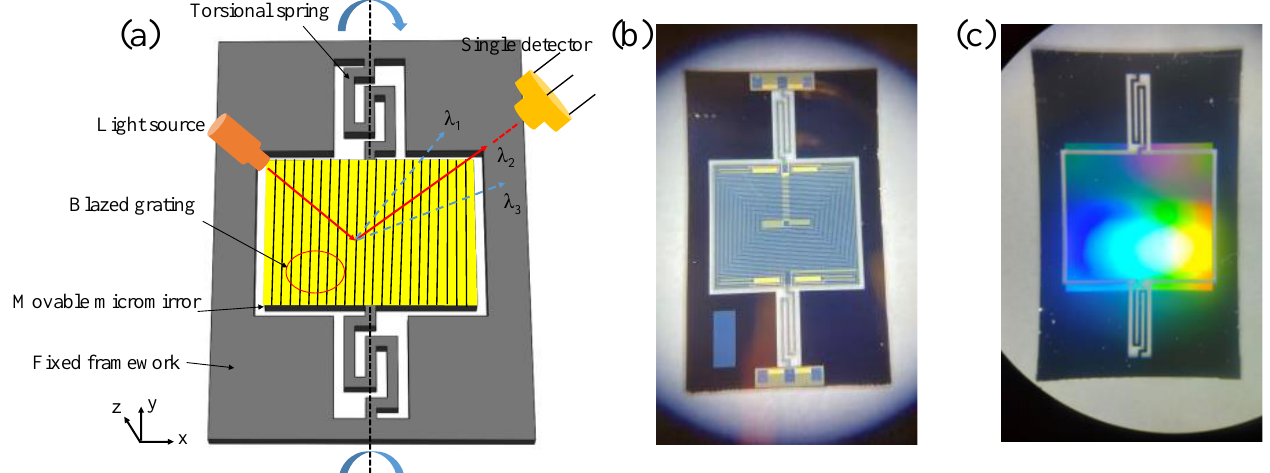
Figure 13. ( a ) Schematic diagram of the scanning grating micromirror; ( b ) frontside of fabricated scanning grating micromirror chip with actuated coils; ( c ) backside of fabricated scanning grating micromirror chip integrated with blazed gratings.